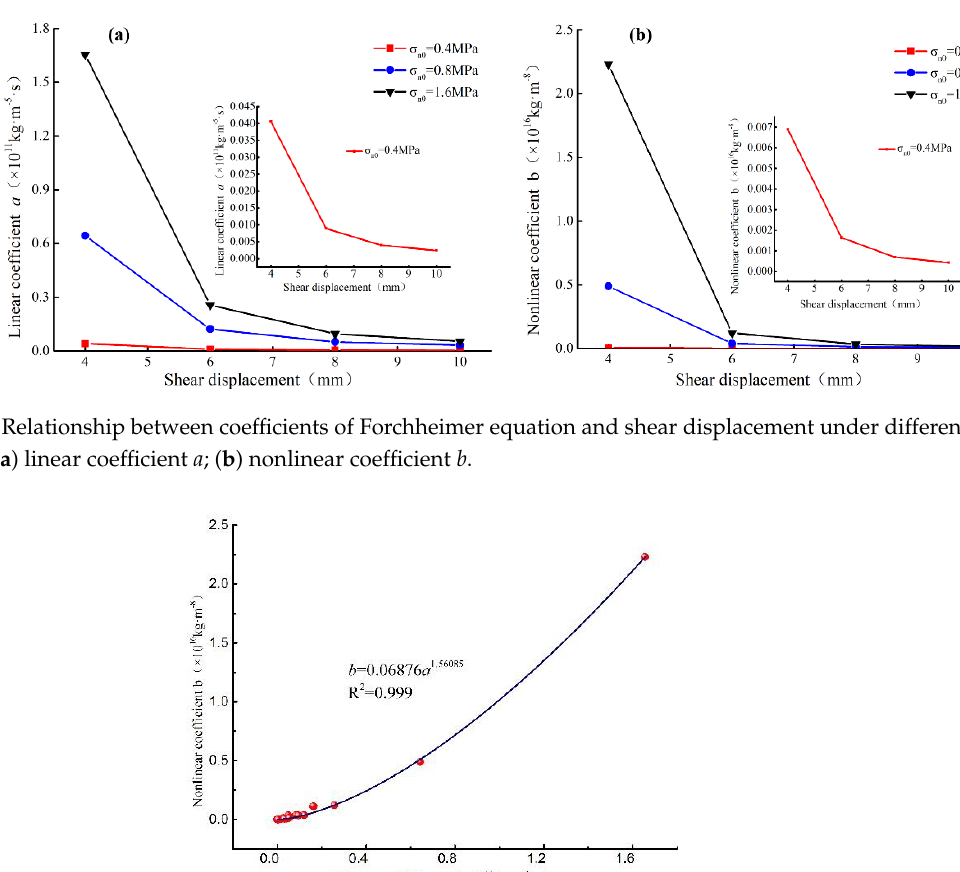
Figure 5. Relationship between pressure gradient and flow rate under different initial normal stresses, ( a ) u h = 4 mm; ( b ) u h = 6 mm; ( c ) u h = 8 mm; ( d ) u h = 10 mm.